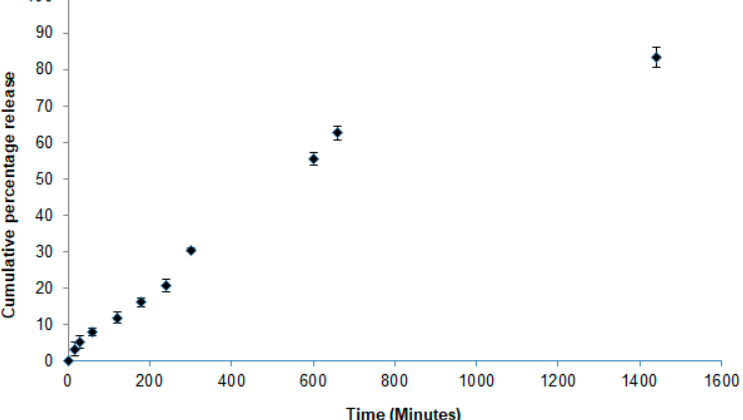
Figure 1. Cumulative percentage release of perillaldehyde 1,2-epoxide from cPa -SLN over 24 h.